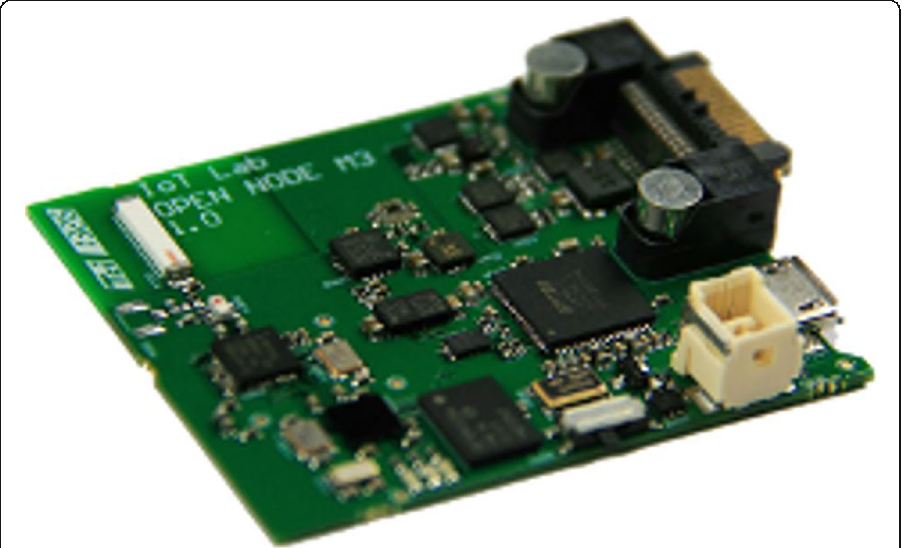
Fig. 6 M3 node. M3 is the sensor chosen to get all the data (Features: 32-bit ARM Cortex